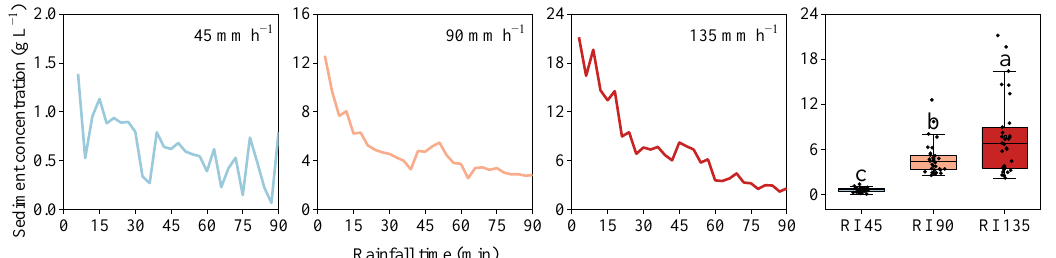
Figure 6. The sediment concentration under different rainfall intensities. Error bars represent standard errors of the means ( n = 30). Bars with different letters differ significantly.